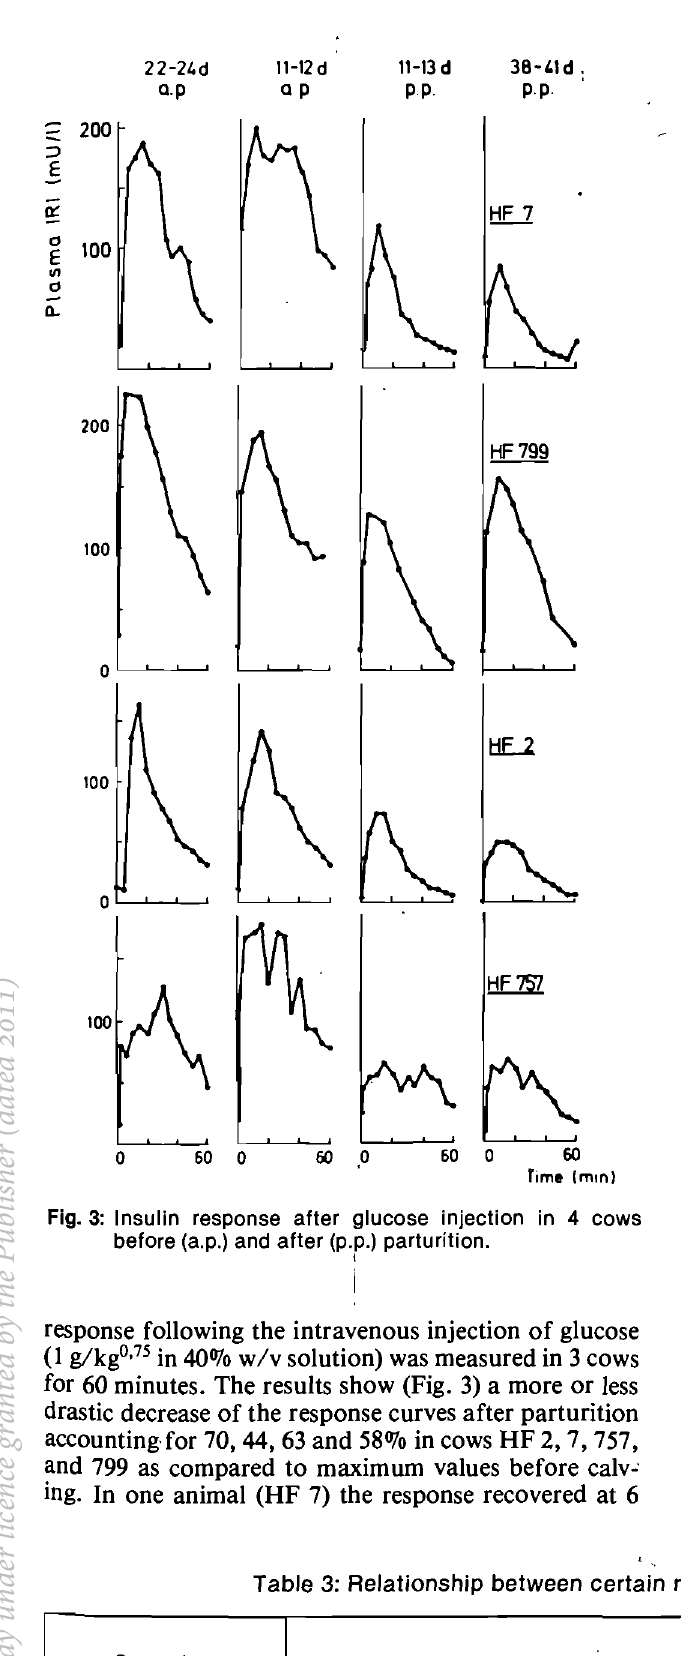
Table 3: Relationship between certain metabolic and reproductive